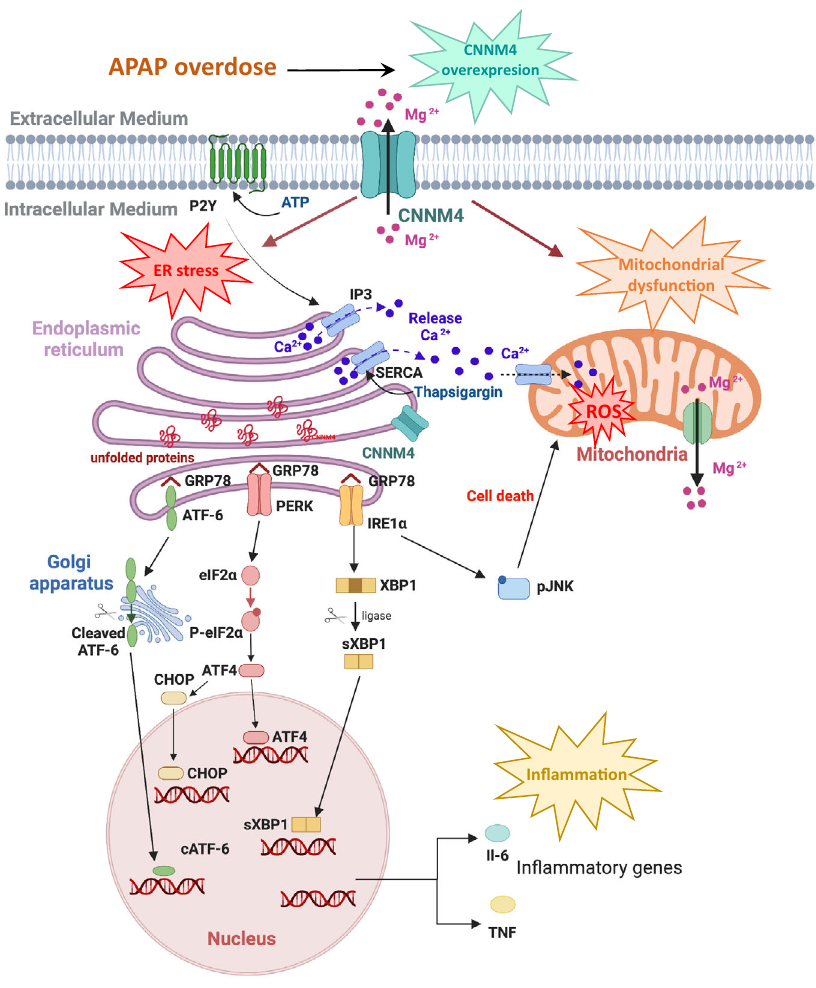
Fig. 8 | Overall mechanisms involved in CNNM4 overexpression caused by APAP overdose. In the liver, APAP overdose leads to increased expression of CNNM4andanenrichmentofitslocalizationintheER.Underthesecircumstances, reticulum stress and mitochondrial dysfunction are induced. The activity